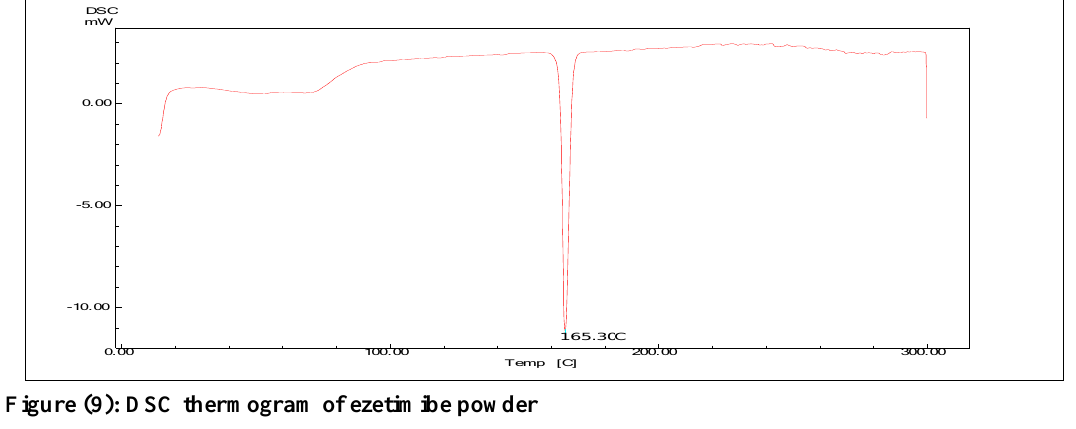
Figure (9): DSC thermogram of ezetimibe powder